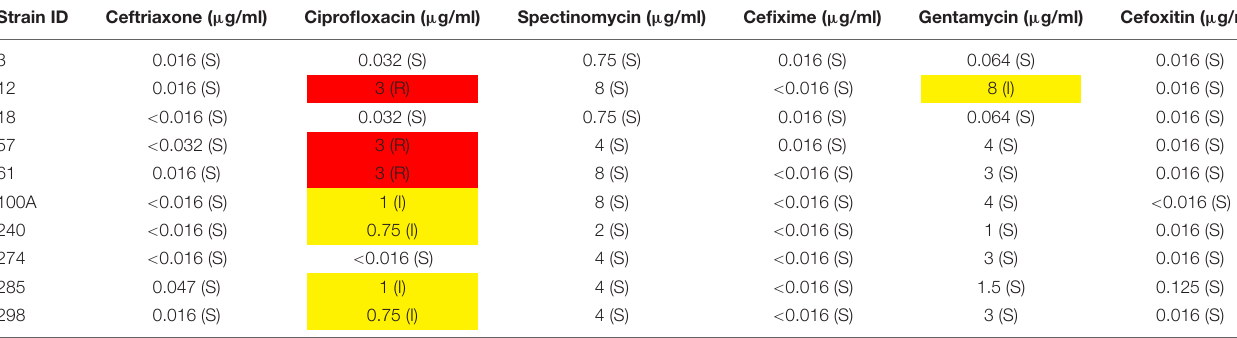
TABLE 2 | MIC values for different antibiotics.